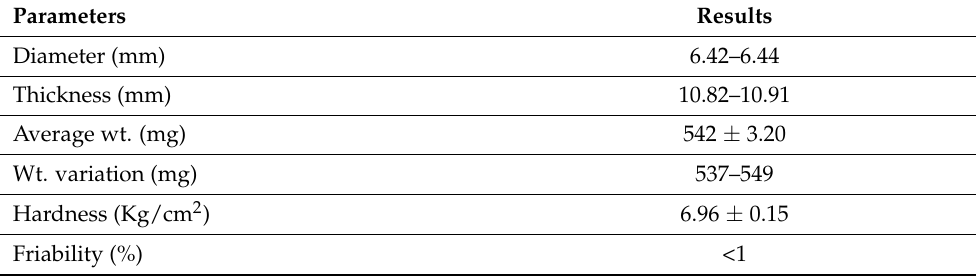
Table 4. Physical evaluation of EC Cologrit